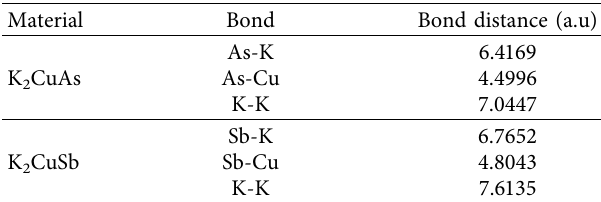
2 CuAs and (b) K 2 CuSb ternary compounds. Table 1: Computed atomic bond lengths within the K K 2 CuSb crystal